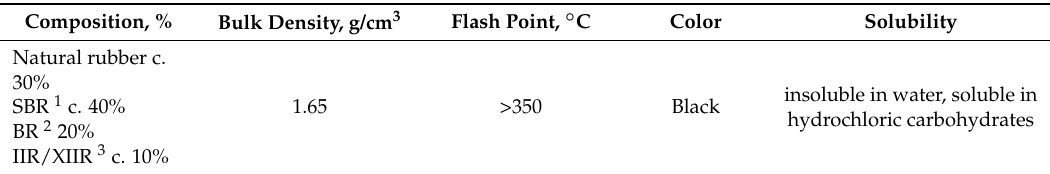
Figure 2. Particle size curves for sand and waste rubber. Table 2. Selected physicochemical properties of the rubber